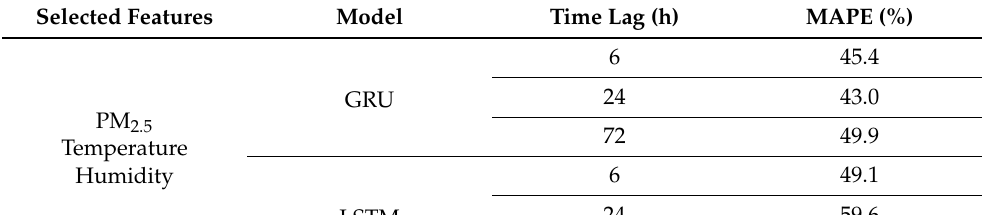
Table 2. Prediction accuracy of different time lags and models with PM 2.5 , temperature, humidity for gated recurrent units (GRU), long short term memory (LSTM) and mean absolute percentage error (MAPE).